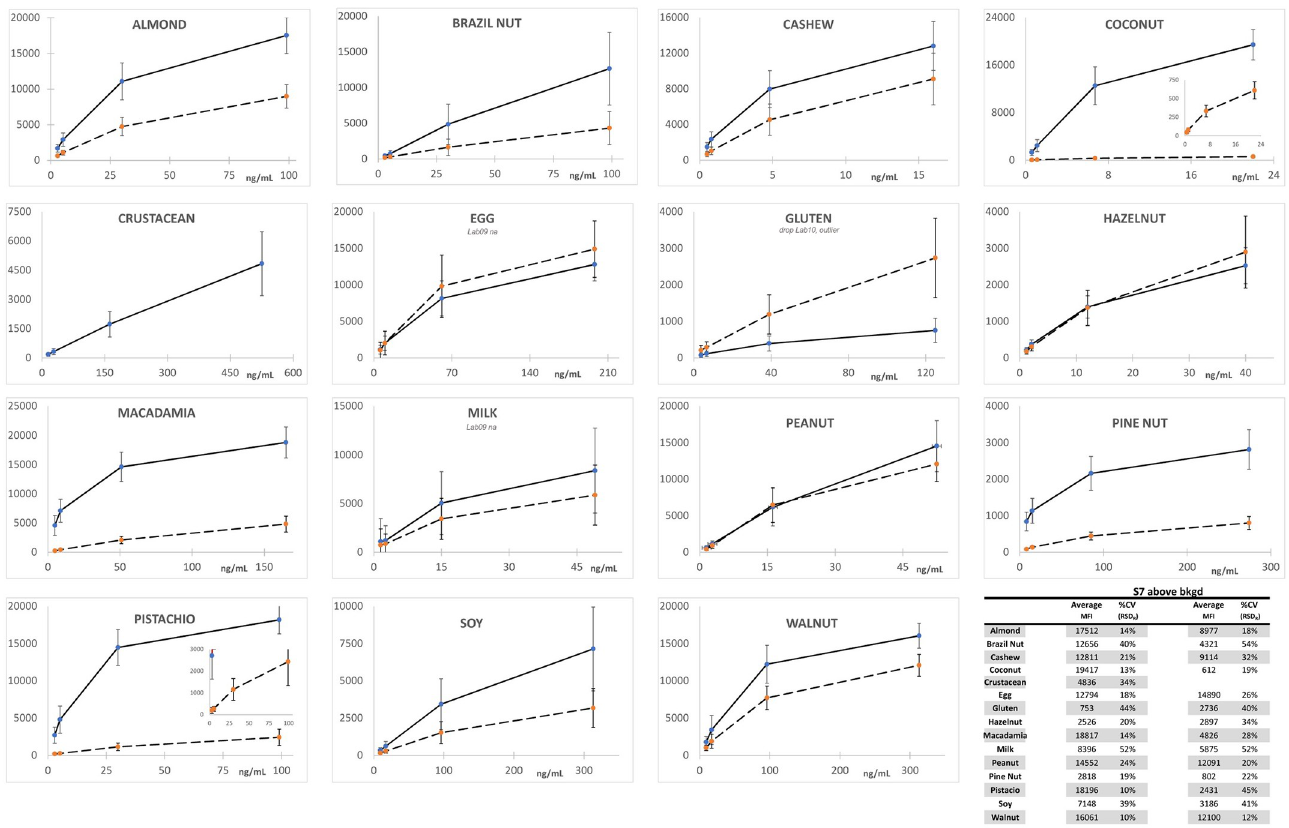
Fig 3. Average of the calibration standards from four experiments, three in PBST and one in UD buffer. Similar to Fig 1 except the average of four sets of calibration standards (3 PBST and 1 UD buffer, n = 11 labs � x 4 exp x triplicate analyses) generated by each participant was used to generate the final data plotted. The lower right corner tabulates the overall average MFI of S7 for each bead set along with the %CV (RSD R ) values across the 11 labs. � The average data from Lab 05 represented only three (2 PBST and 1 UD buffer) experiments, Lab 09 did not collect any data for the egg (-25, -26) or milk (-35, -36) bead sets and the gluten data generated by Lab 10 were classified as outliers (exceptionally high background resulted in background adjusted MFI < 0 for S1 and S2) and not